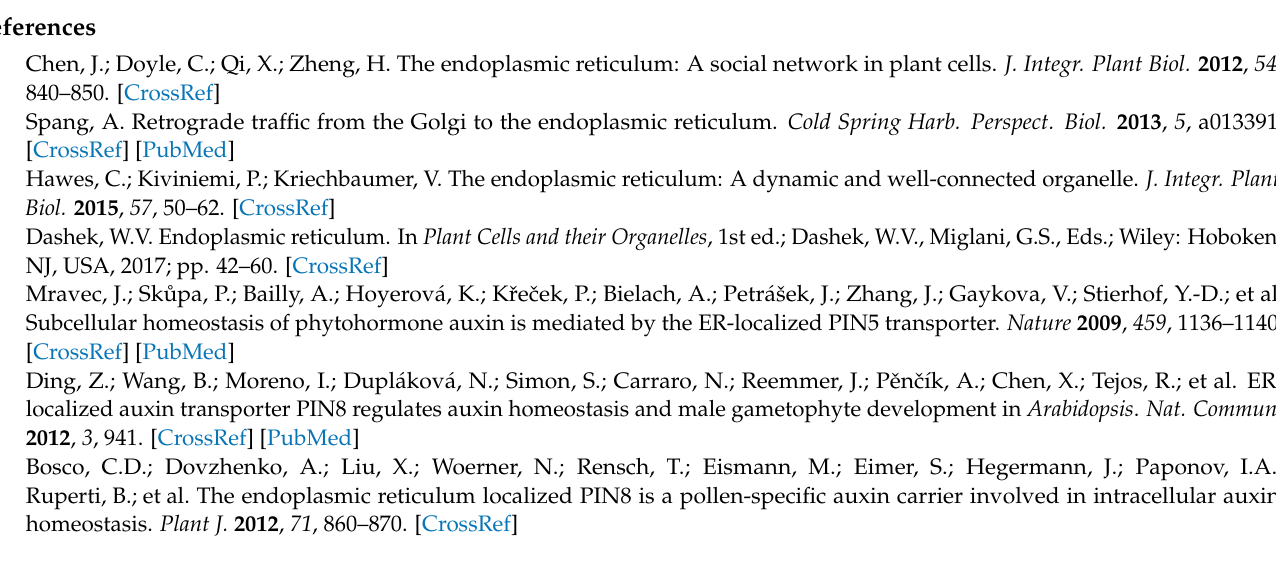
Figure S4: KEGG pathway enrichment analysis; Figure S5: Total process efficiency (%) of solid-phase extraction (SPE) protocols; Table S1: Protein and peptide identification characteristics for analyses of ER isolates and control samples; Table S2: A list of all identified proteins assigned as ER-located; Table S3: Complete functional annotation clustering results for the proteins assigned as